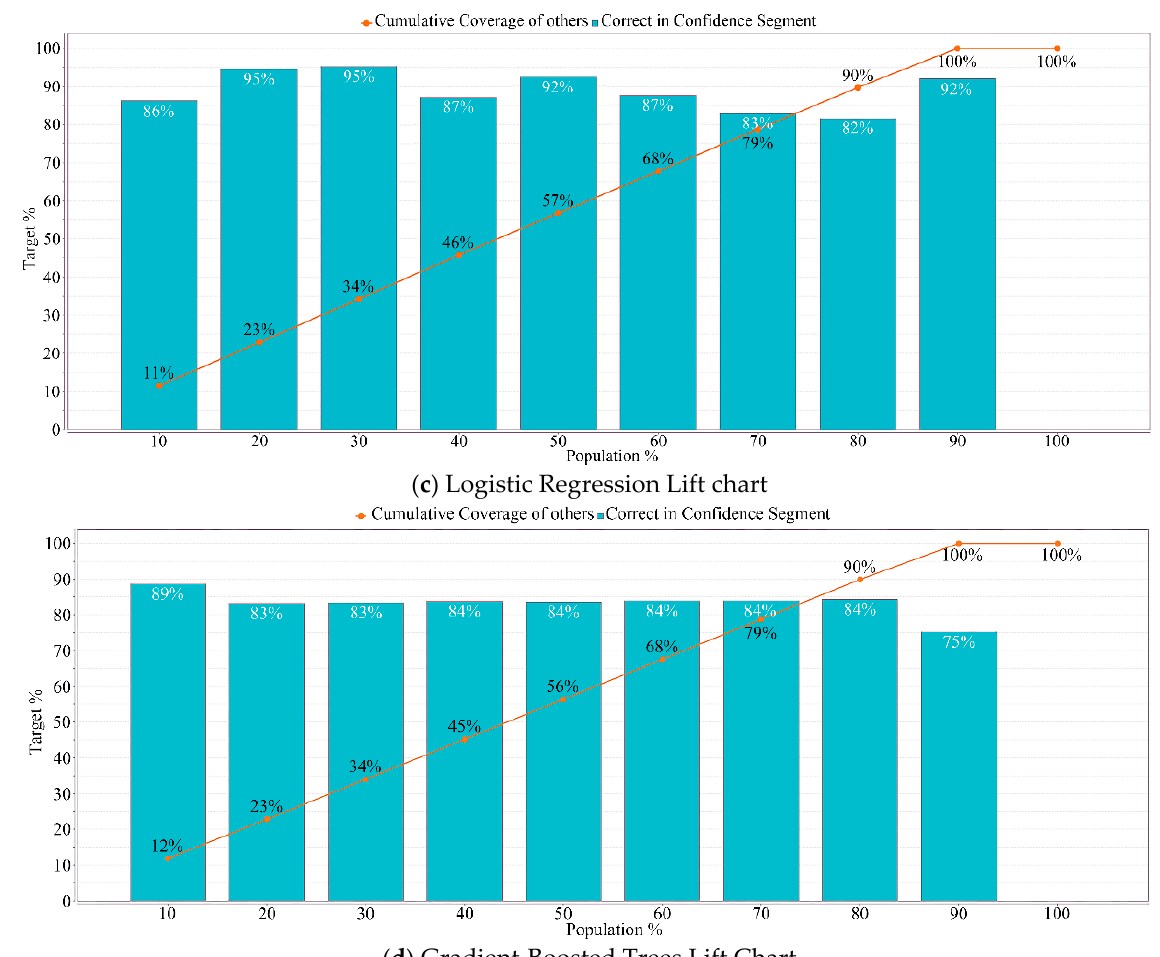
Figure 7. ( a – d ) . Lift chart of proposed